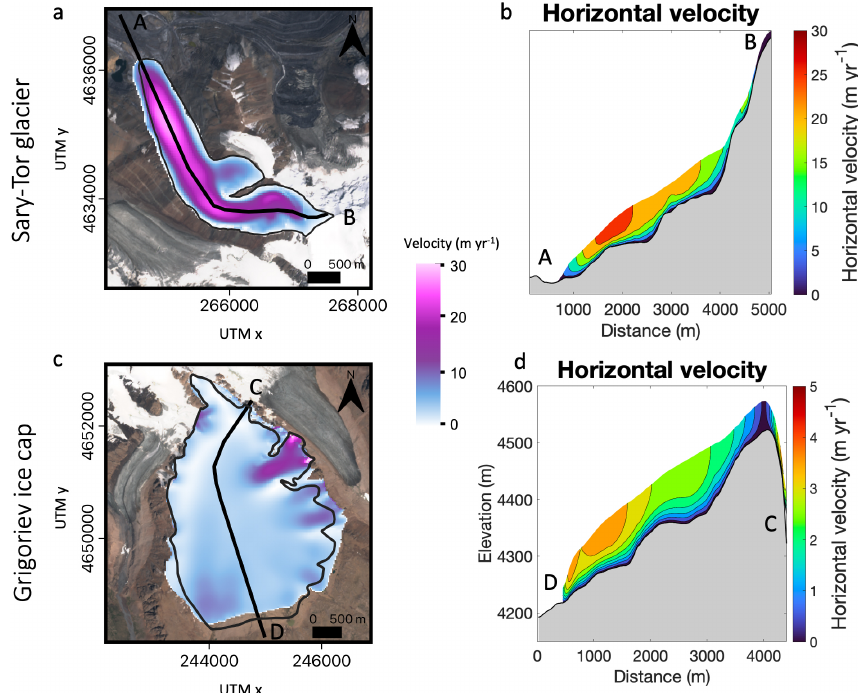
Figure 8. (a, c) Horizontal surface ice velocities of the Grigoriev ice cap and the Sary-Tor glacier. The flowline is added on the map with a black line. (b, d) Horizontal ice velocities along the flowlines of both ice masses. Panels (a) and (b) are for the Sary-Tor glacier, and panels (c) and (d) are for the Grigoriev ice cap. The background of the left maps is a Sentinel-2 image from 26 July 2021. The outlines are from 1990.